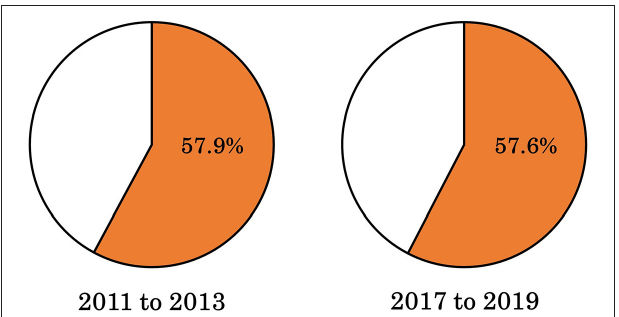
FIGURE 1 | Percentage of papers published in the Journal of Epidemiology addressing the top seven research topics (cardiovascular disease, diabetes, cancer, physical activity, nutrition, tobacco, alcohol or internet addiction, and social epidemiology) in 2011–2013 and